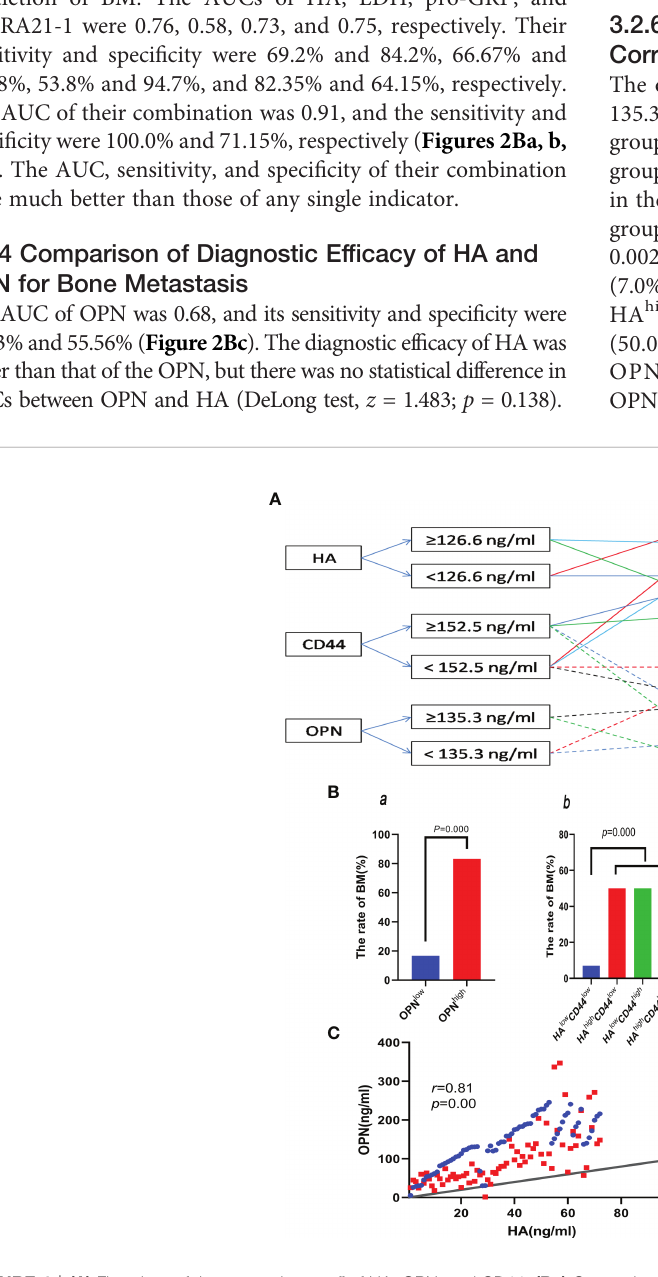
FIGURE 4 | (A) Flowchart of the groups by cutoff of HA, OPN, and CD44. (Ba) Comparing the rate of BM between the OPN low and OPN high groups. (Bb, c) Comparing the rate of BM between the different groups divided by the cutoff of HA, OPN, and CD44 in the plasma. (C) Correlation between HA and